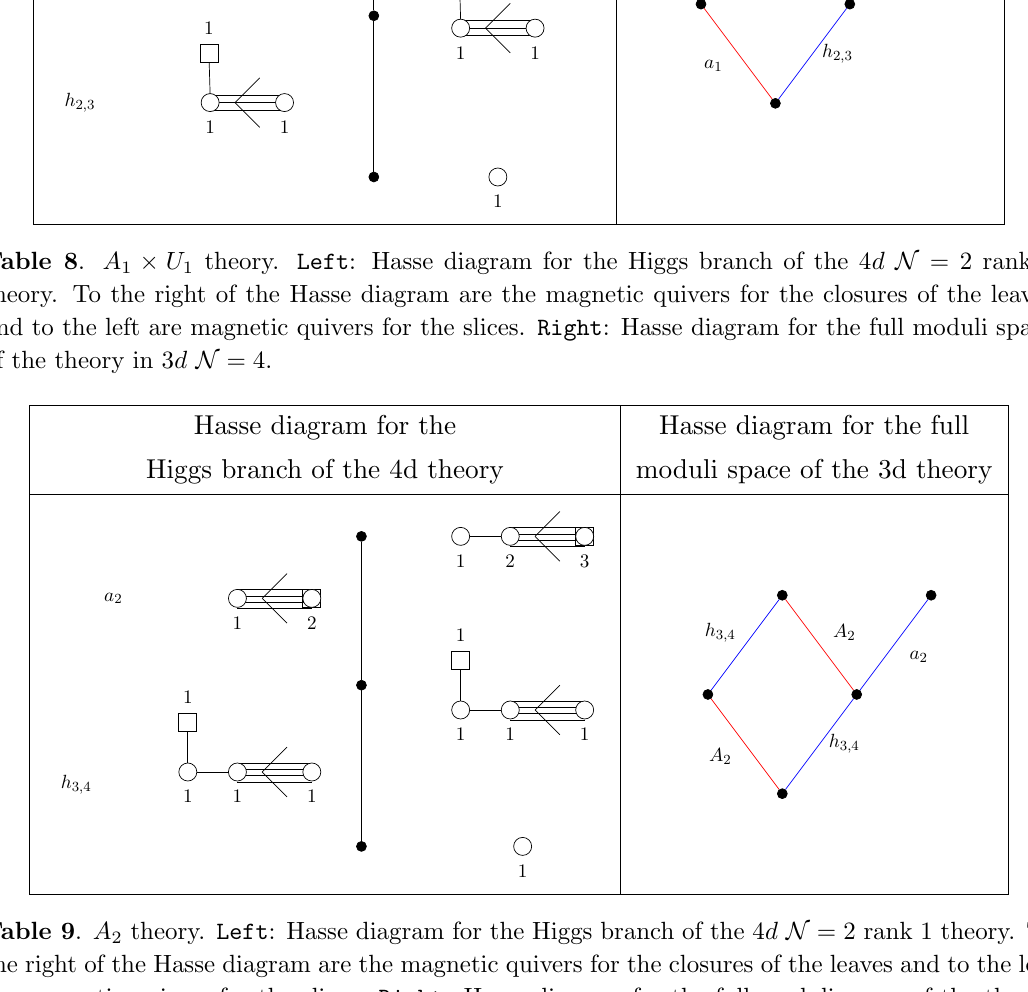
= 2 rank 1 theory. To N